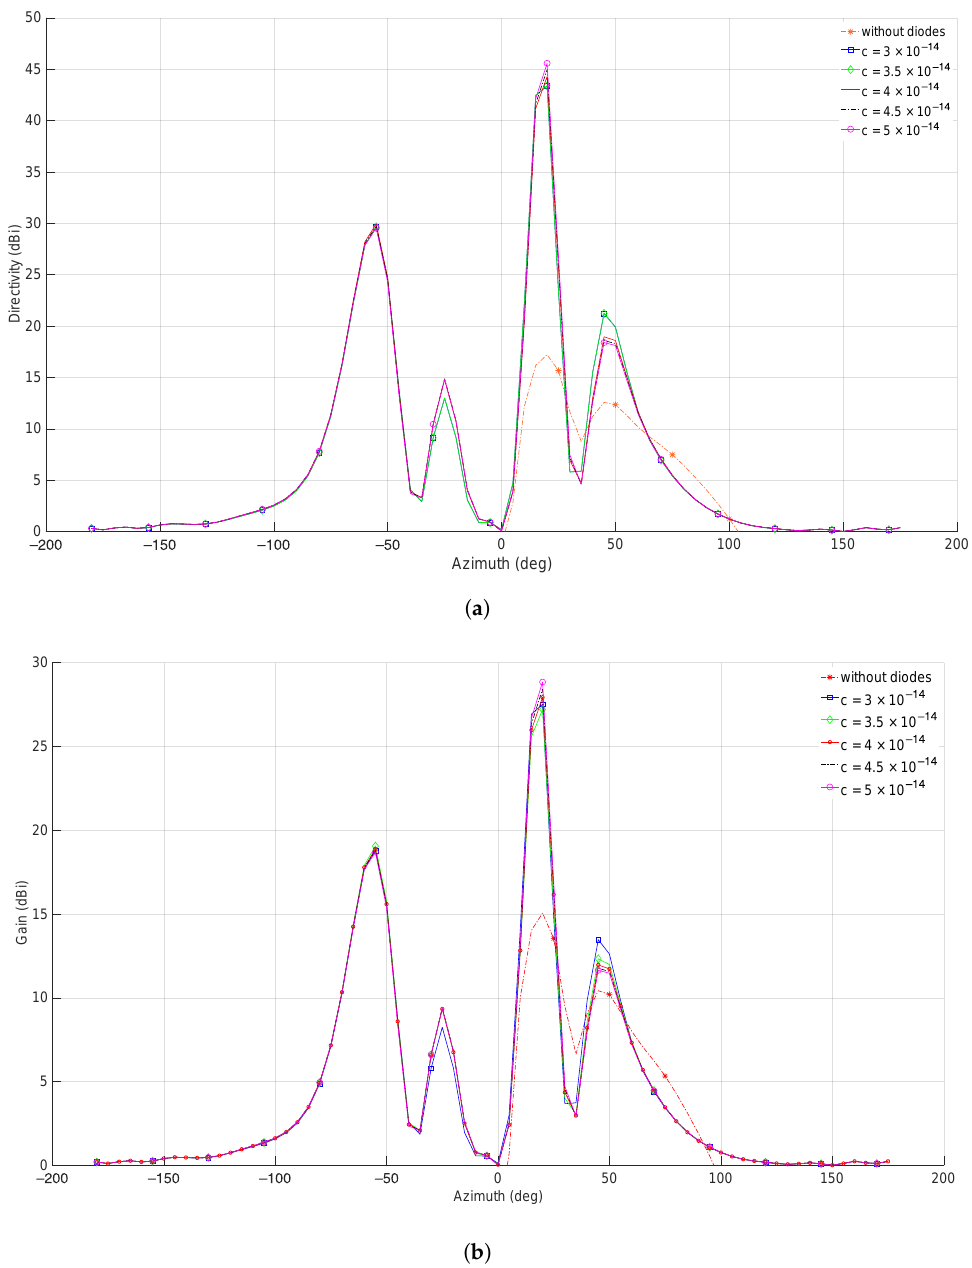
Figure 9. Simulation results of a 16 element metasurface array with and without PIN diodes indicating ( a ) Directivity ( b )